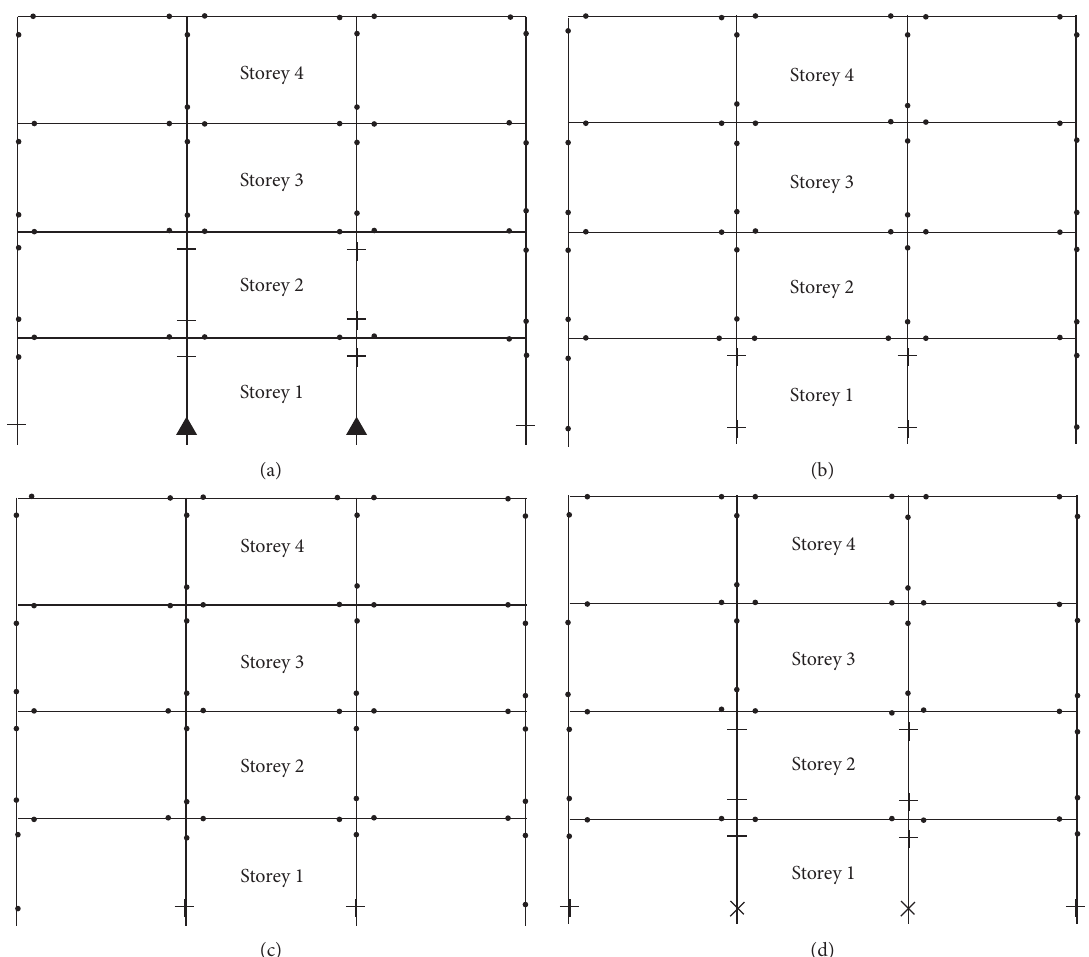
Figure 16: Damage distribution in frames. (a) Original, (b) RS1, (c) RS2, and (d) RS0.